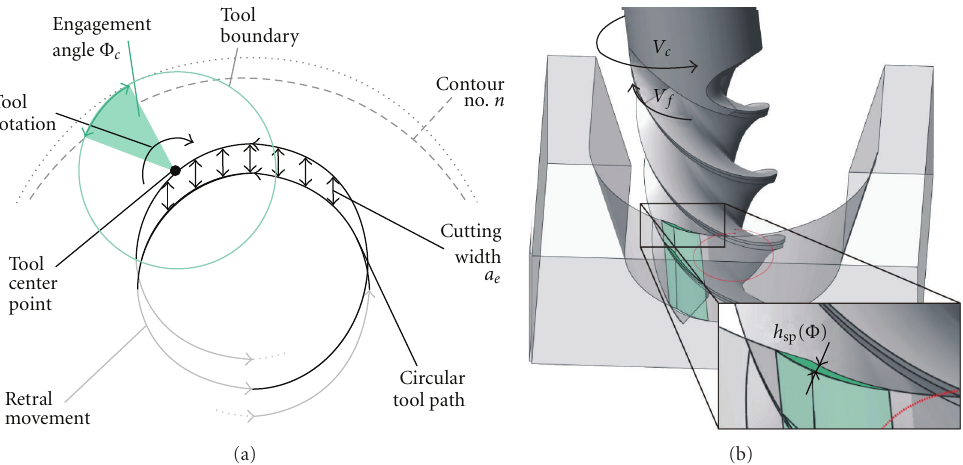
Figure 3: Macroscopic (a) and microscopic (b) contact conditions of circular milling.